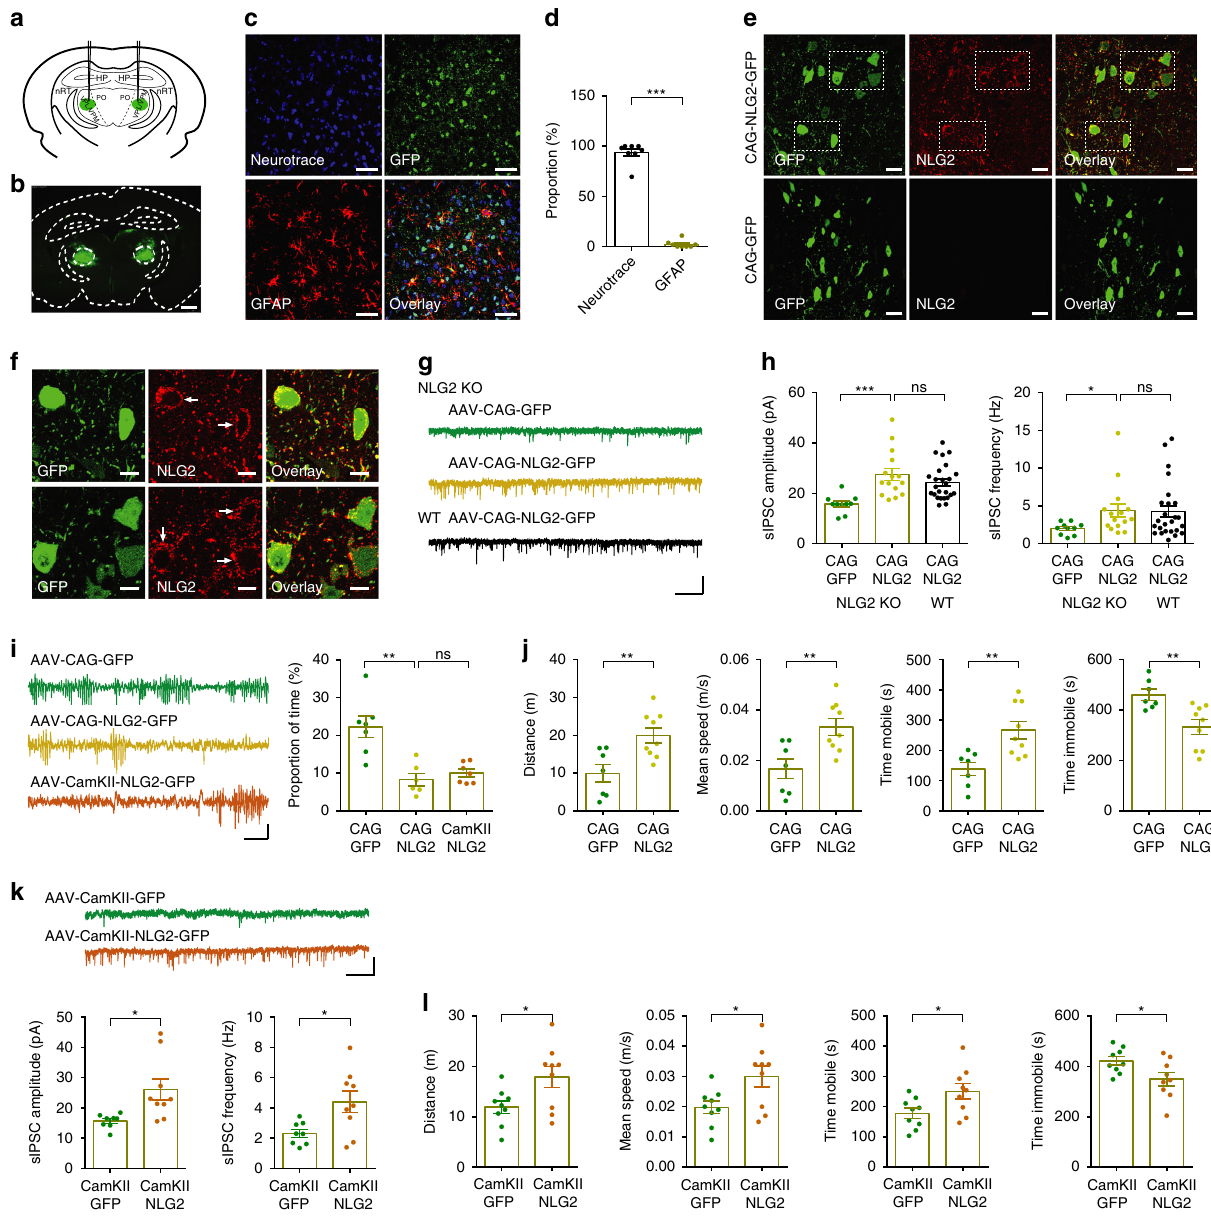
Fig. 7 Reintroducing NLG2 to ventrobasal thalamus reduces synaptic and behavior de fi cits in NLG2 KO mice. a Injection sites of AAV-NLG2-GFP viruses in the ventrobasal thalamus. b Expression of AAV-NLG2-GFP. Scale bar: 1 mm. Images are representatives of fi ve replicates. c Expression of NLG2- GFP (green), Neurotrace (blue) and GFAP (red) in cortical sections infected with AAV-NLG2-GFP viruses. Scale bars: 50 μ m. Images are representatives of three replicates. d Summary graph of cortical staining showing NLG2-GFP colocalized with Neurotrace but not GFAP ( p < 0.0001, n = 8). e Expression of NLG2 (red) in NLG2 KO mice injected with CAG-NLG2-GFP, but not in NLG2 KO mice injected with CAG-GFP control viruses. Scale bars: 20 μ m. Images are representatives of six replicates. f High-magni fi cation images showing expression of NLG2 (red, arrows) on thalamic neuronal surface (green) in NLG2 KO mice injected with CAG-NLG2-GFP viruses. Scale bars: 10 μ m. Images are representatives of six replicates. g Sample traces of sIPSCs in NLG2 KO and WT mice injected with CAG-NLG2-GFP or CAG-GFP viruses. Scale bar: 1 s/20 pA. h Increased sIPSC amplitude ( p = 0.0009) and frequency ( p = 0.0437) in NLG2 KO thalamic neurons expressing CAG-NLG2-GFP ( n = 15) compared to CAG-GFP ( n = 10). Similar sIPSC amplitude ( p = 0.2363) and frequency ( p = 0.8983) between WT ( n = 25) and NLG2 KO ( n = 15) thalamic neurons expressing CAG-NLG2-GFP. i Decreased SWDs ( p = 0.0019) in NLG2 KO mice virally expressing CAG-NLG2-GFP ( n = 6) compared to CAG-GFP control ( n = 7), and a similar reduction ( p = 0.3858) in SWDs with viral expression of CAG-NLG2-GFP ( n = 6) compared with CamKII-NLG2-GFP ( n = 7). Scale bar: 2 s/100 μ V. j Increased travel distance ( p = 0.006), speed ( p = 0.0058), mobile time ( p = 0.0048), and decreased immobile time ( p = 0.0048) in NLG2 KO mice injected with CAG-NLG2-GFP ( n = 9) compared to control CAG- GFP viruses ( n = 7). k Increased amplitude ( p = 0.0153) and frequency ( p = 0.0185) in NLG2 KO thalamic neurons virally expressing CamKII-NLG2-GFP ( n = 9) compared to CamKII-GFP control ( n = 8). Scale bar: 1 s/20 pA. l Increased travel distance ( p = 0.0265), speed ( p = 0.0235), mobile time ( p = 0.0315), and decreased immobile time ( p = 0.0316) in NLG2 KO mice injected with CamKII-NLG2-GFP ( n = 9) compared to control CamKII-GFP